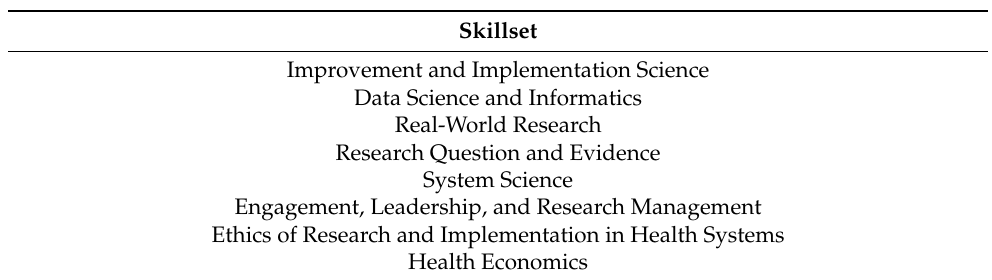
Table 2. Competencies of IS lab